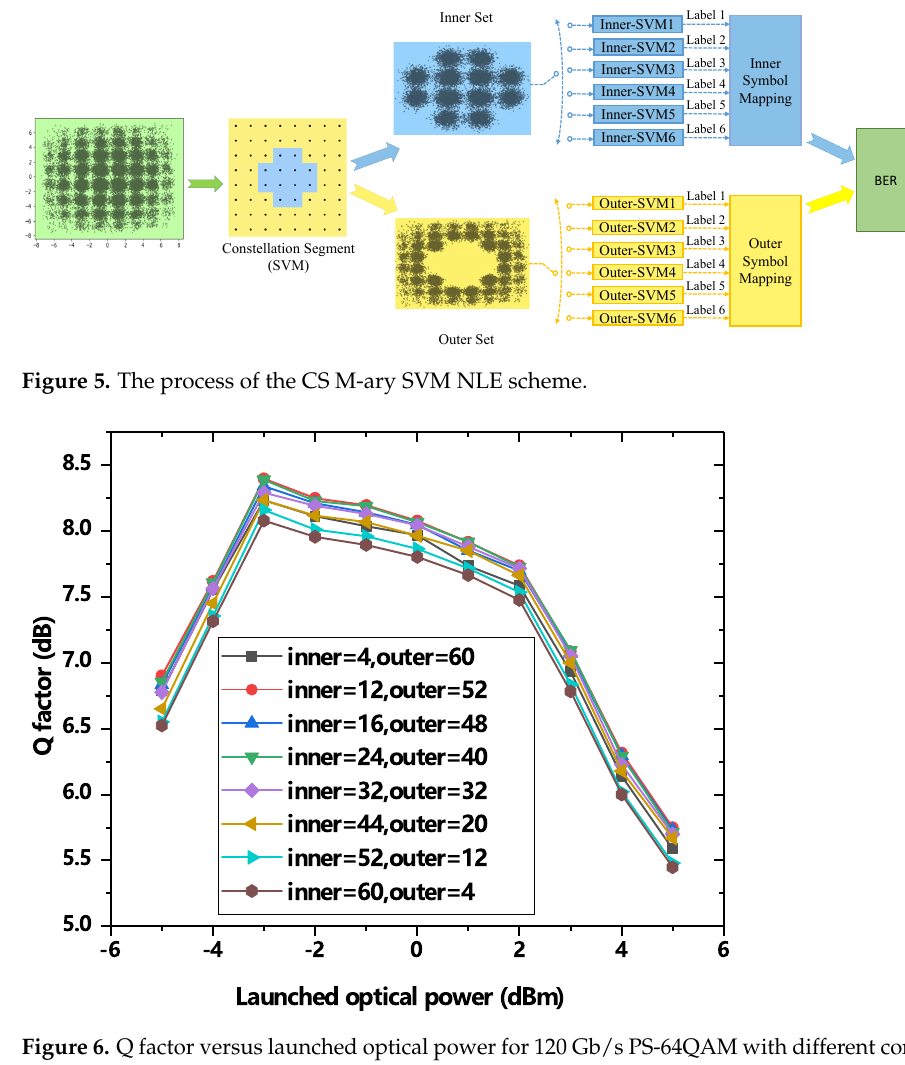
Figure 6. Q factor versus launched optical power for 120 Gb/s PS-64QAM with different constellation segment methods. Table 1. The amplitude and probability distributions of the standard PS-64QAM constellation ( v = 0.05). The Number of The Amplitude of Each Constellation Points Constellation